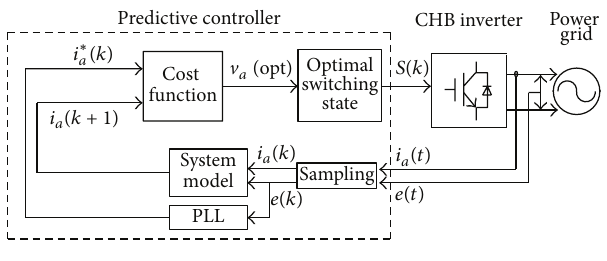
Figure 2: Block diagram of the FS-MPC